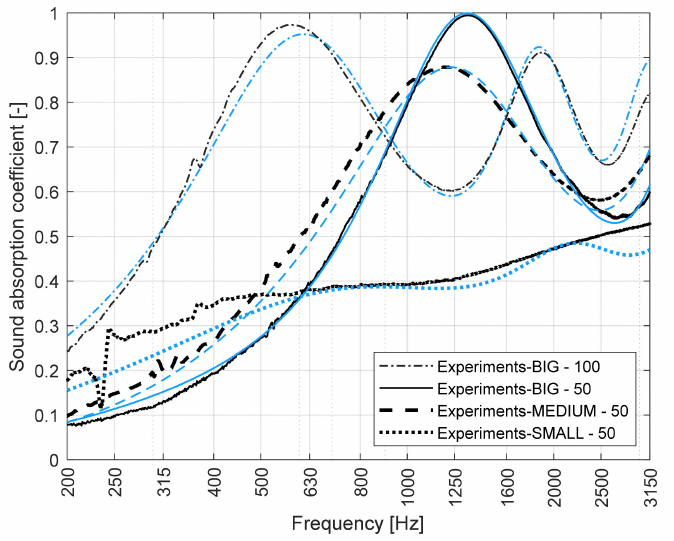
Figure 12. Comparison between experimental and predicted sound absorption coefficients for slag spheres samples BIG, MEDIUM and SMALL. Blue lines are referred to the respective JCA fittings.